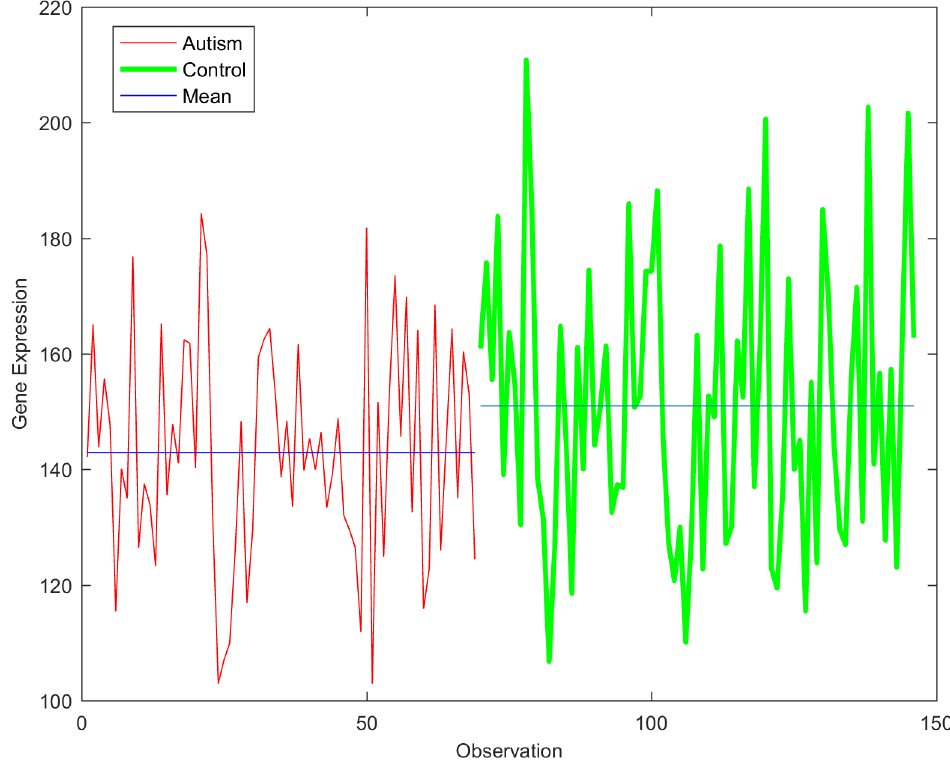
Fig 4. Expression of a representative gene in samples from control and autistic